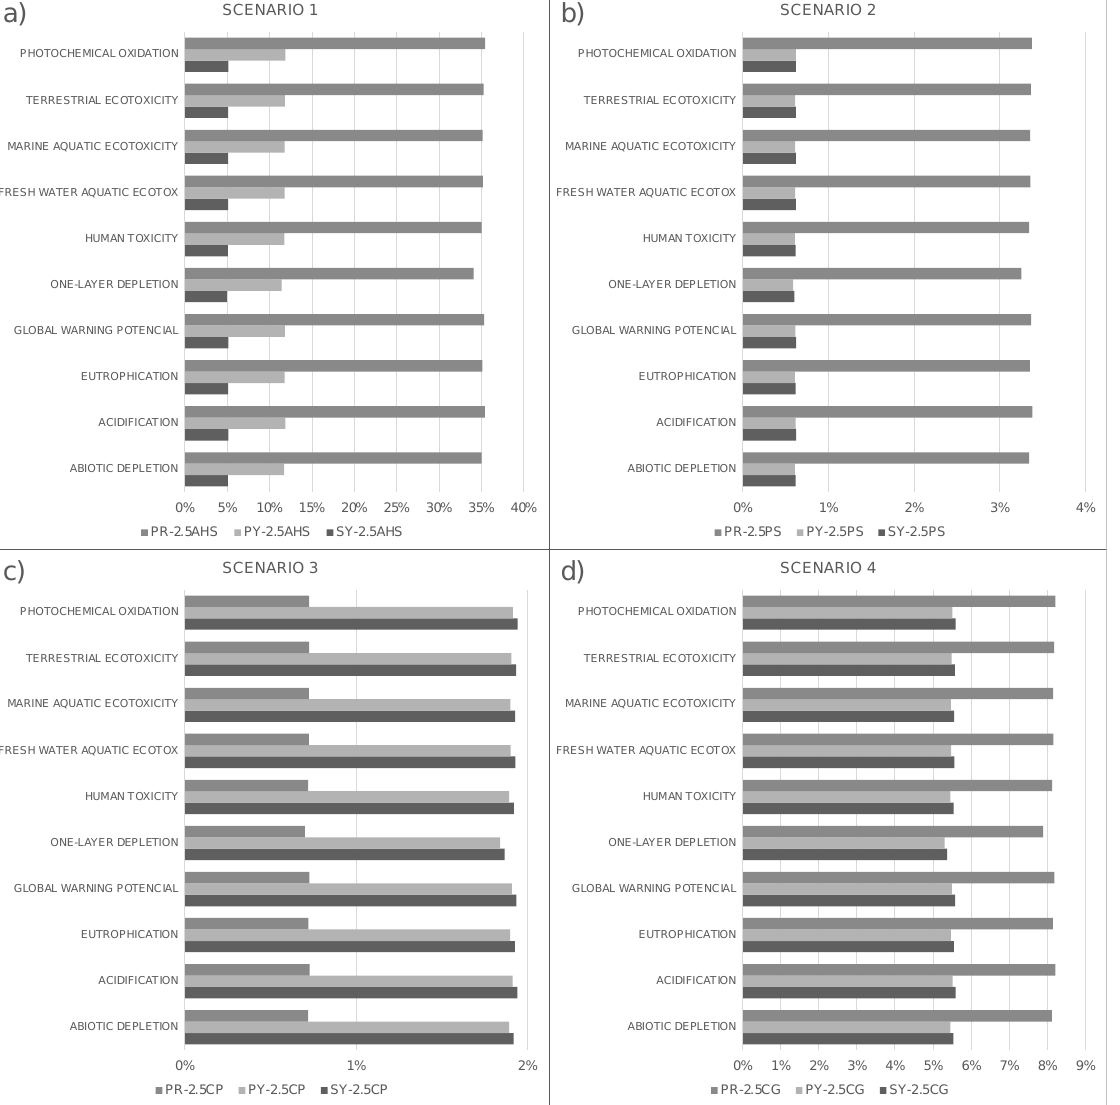
Figure 5. Comparison of the environmental benefits of the impacts characterized between light aggregates produced with 2.5 wt % waste in Scenarios 1 ( a ), 2 ( b ), 3 ( c ) and 4 ( d ) at the MANUFACTURING stage.